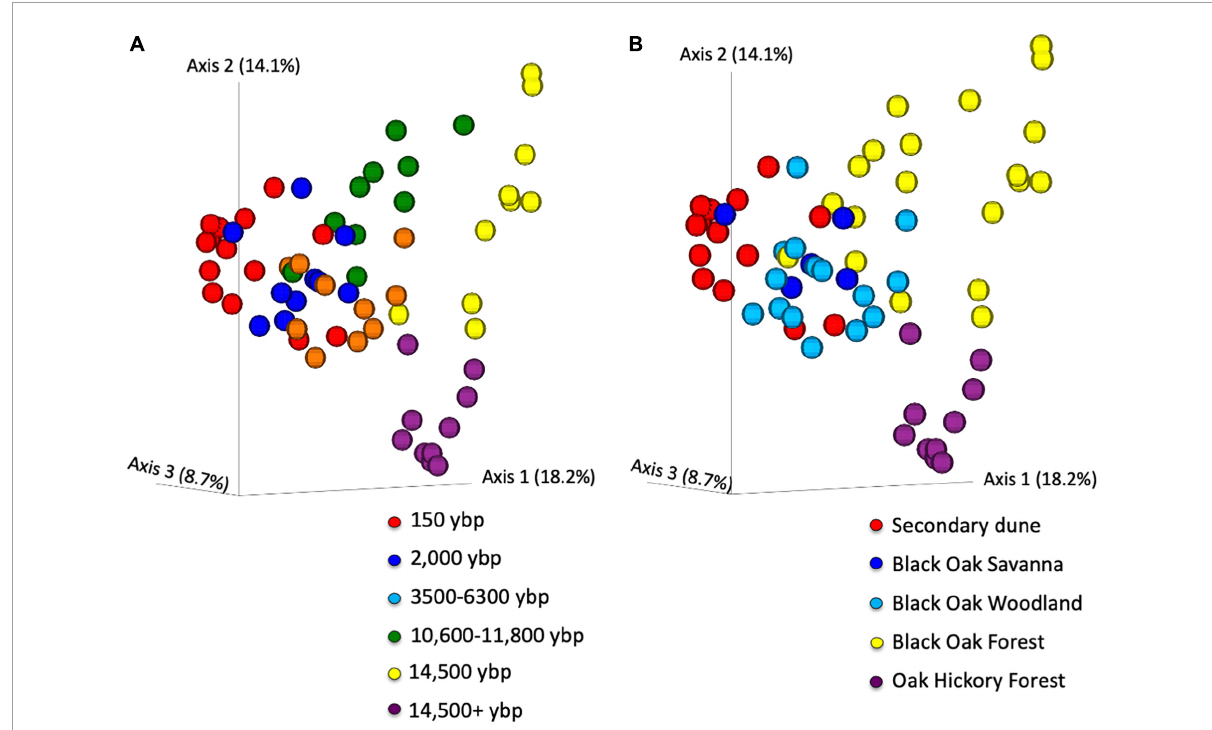
FIGURE4 Principal coordinate analysis of unweighted Unifrac beta diversity metrics of Asiatic bittersweet rhizosphere bacterial communities. Data points colored by (A) geologic age of soils (ybp- years before present), and (B) habitat type. perMANOVA comparisons of samples by age or habitat, overall differences significant p = 0.001 and all pairwise comparisons q < 0.02. Overall permDISP comparison also significant p < 0.03 for age and habitat. Pairwise analysis indicates that dispersion differences are significant ( p < 0.05) between over 14,500 + y samples and all other ages except 14,000 y. For habitats, pairwise permdisp differences significant ( p < 0.04) for oak hickory forest compared to secondary dune and to black oak forests, also black oak woodland compared to secondary dune and black oak forests. Samples were collected at Indiana Dunes National Park in